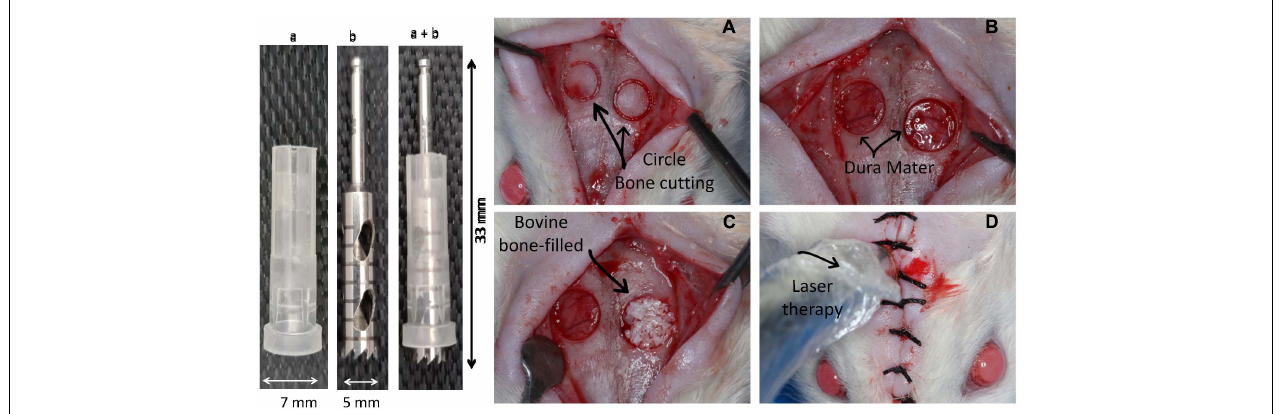
FIGURE 1 | Device and approach used to induce bone damage in the head of Wistar rats. In the left side is shown the device used to remove a circular 5-mm-diameter and 2-mm-deep bone area on the top of a rat. The device was constructed by using a 7-mm-diameter protective plastic tube (“a”) covering a metallic diamond bur (“b”) and the mounted device (“a” + “b”). In the right side is illustrated the sequential steps of the surgical approach. (A) Shows the area delimited by the cutting device; (B) illustration of the integrity of the dura mater after removing the bone; (C) right side cavity filled with inorganic bovine bone (IBB); (D) radiation of the cavities with a low-level laser device.